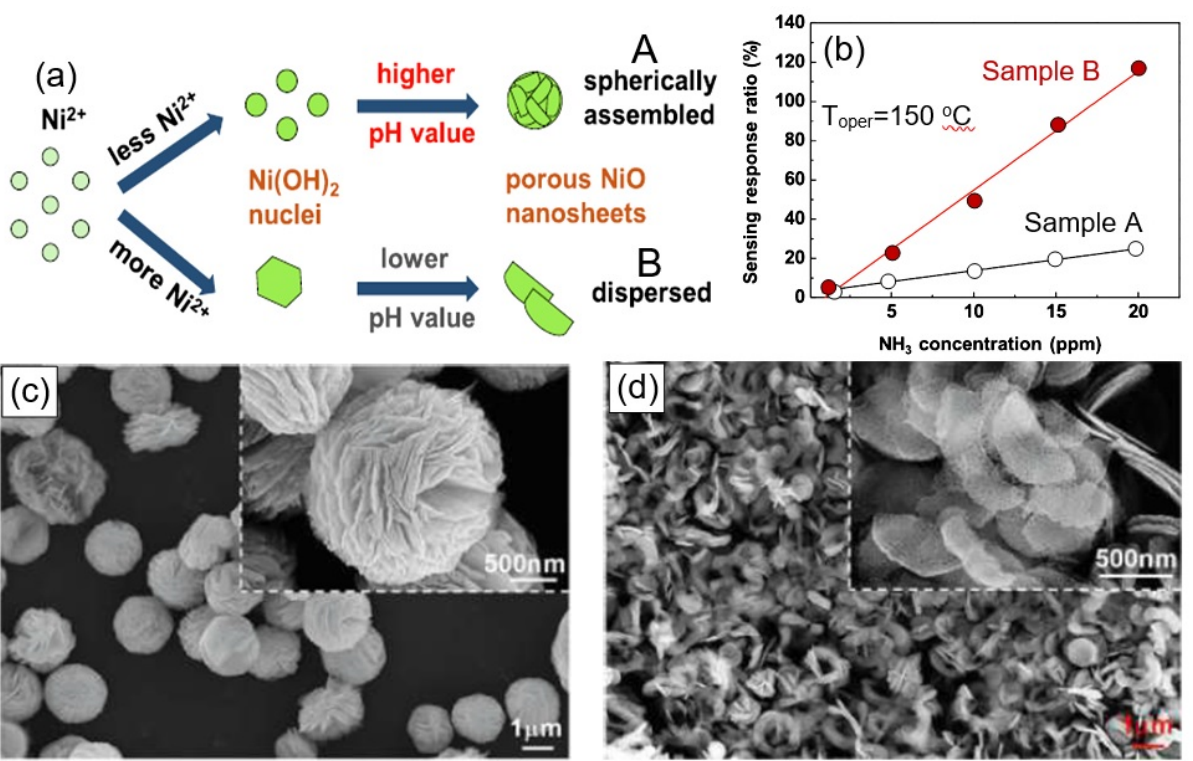
Figure 21. ( a ) Growing mechanism of spherically-assembled (A) and dispersed porous NiO nanosheets (B). ( b ) Sensing-response ratio to different ammonia gas concentrations for samples A and B. ( c , d ) SEM images of ( c ) spherically-assembled porous NiO nanosheets and ( d ) dispersed porous NiO nanosheets. Reprinted with permission from Juang et al. [151]. Copyright 2022: Elsevier.